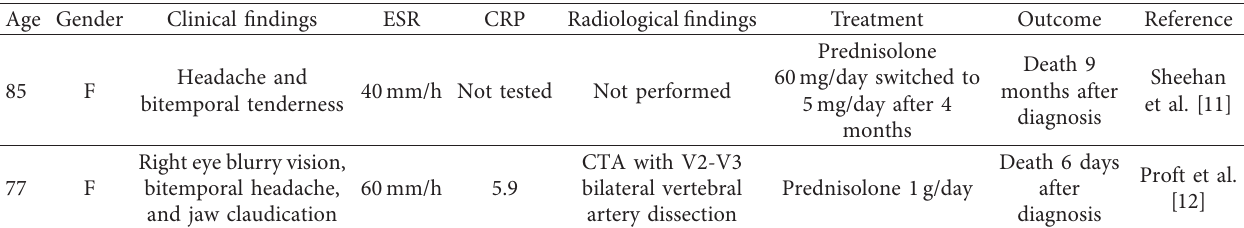
Table 1: Comparison of patients’